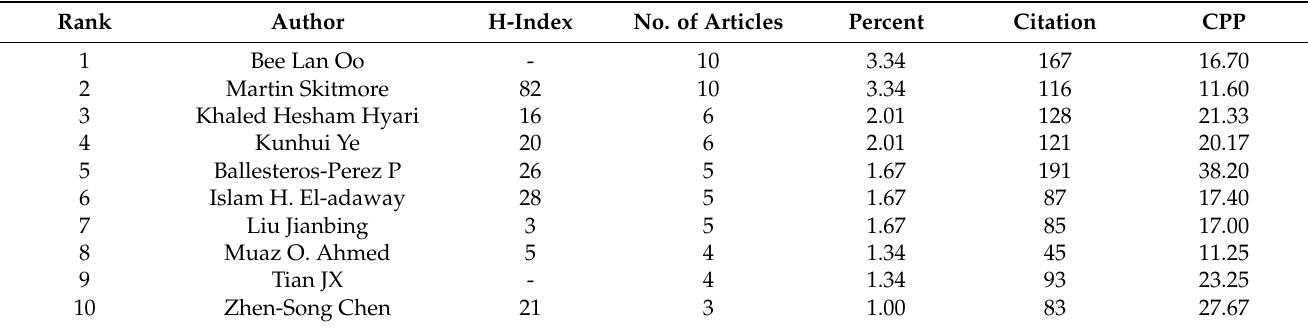
Table 4. Top 10 authors with the highest number of articles.